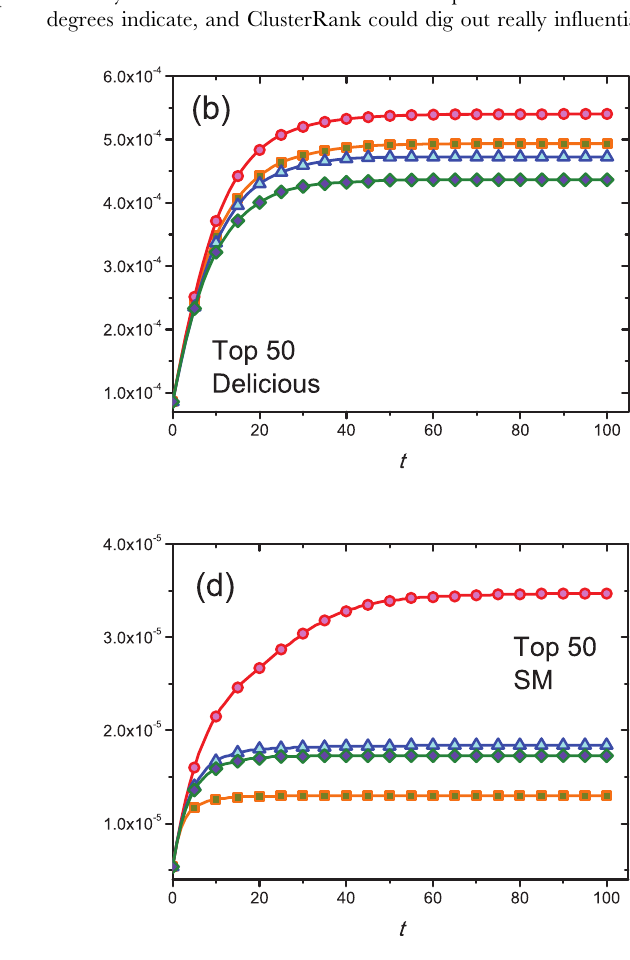
Figure 4. F ( t ) for top- L ranked nodes by out-degree centrality (squares), PageRank (diamond), LeaderRank (triangle) and ClusterRank (circles). We set l ~ 1 : 2 and b ~ 1 = S k out T . Each data point is obtained by averaging over 100 independent runs.